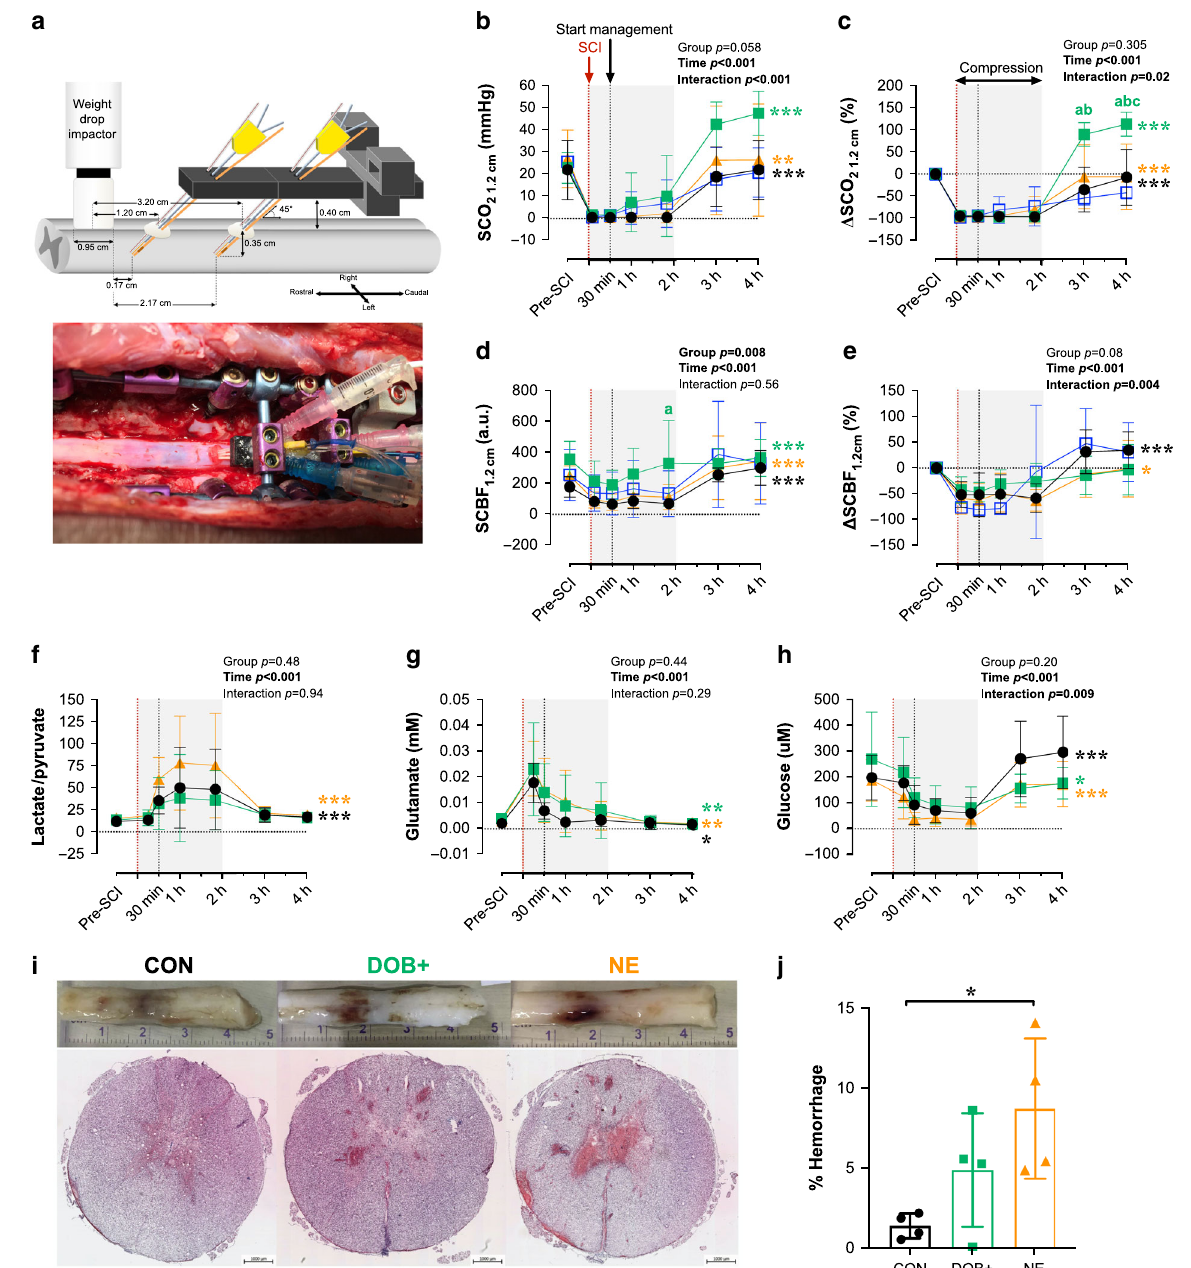
Fig. 4 Impacts of dobutamine (DOB) and norepinephrine (NE) on the spinal cord acutely post-SCI. a Setup for intraparenchymal monitoring. A fi xation device is secured to the spinal column and probes are inserted through the dura 1.2 cm and 3.2 cm caudal to the center of the impactor. All data are shown for 1.2 cm probes. Data from 3.2 cm probes are provided in Supplementary Table 6. b Data points are means and error bars represent s.d. for animals receiving no treatment (control, CON; n = 8), high-dose DOB (DOB + ; n = 4), low-dose DOB (DOB − ; n = 3), and NE ( n = 7). Improvements to spinal cord oxygenation (SCO 2 ) occur after decompression (i.e. 2 h post-SCI), but are most pronounced in DOB + . c When expressed as a percent change form baseline, Δ SCO 2 is signi fi cantly augmented in DOB + compared to all groups by 4 h post-SCI. d Spinal cord blood fl ow (SCBF) is augmented in CON, NE, and DOB + following decompression, and DOB + notably augmented absolute SCBF at 2 h post-SCI. e However, when expressed as percent change from baseline, SCBF was only altered in CON and NE over the treatment period. f The lactate/pyruvate ratio does not signi fi cantly increase after management onset (i.e. 30 mins post-SCI) with DOB + , but is increased in NE and CON. g In all groups, glutamate becomes progressively reduced and h glucose is increased following decompression (i.e. 2 h post-SCI). Suf fi cient microdialysis data were only acquired in n = 2 for DOB − , thus DOB − data were excluded from analyses. i Representative cords and histological stains show pronounced hemorrhaging with NE. Measures of hemorrhage were averaged over fi ve separate sections per animal. j Animals receiving NE have augmented hemorrhaging at the injury epicentre, which is mitigated by DOB + . See Fig. 3 for symbol de fi nitions and statistical details. * p < 0.05, ** p < 0.01, *** p < 0.001. a p < 0.05 vs CON; b p < 0.05 vs DOB-; c p < 0.05 vs NE. Within-group comparisons between 30 mins and 1 h to 3 h post-SCI are available in Supplementary Tables 6 and 7. Source data are provided as a Source Data fi